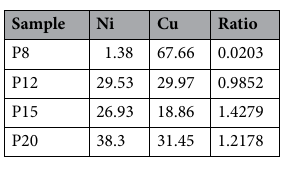
Table 3. Ni:Cu ratio acquired from EDX.